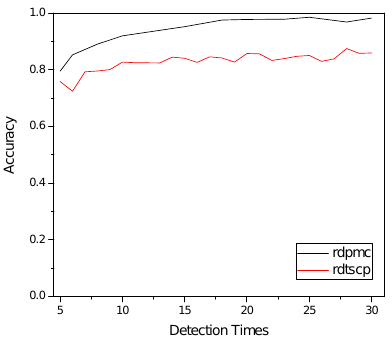
Figure 10: The accuracy of the two measurements with different detection